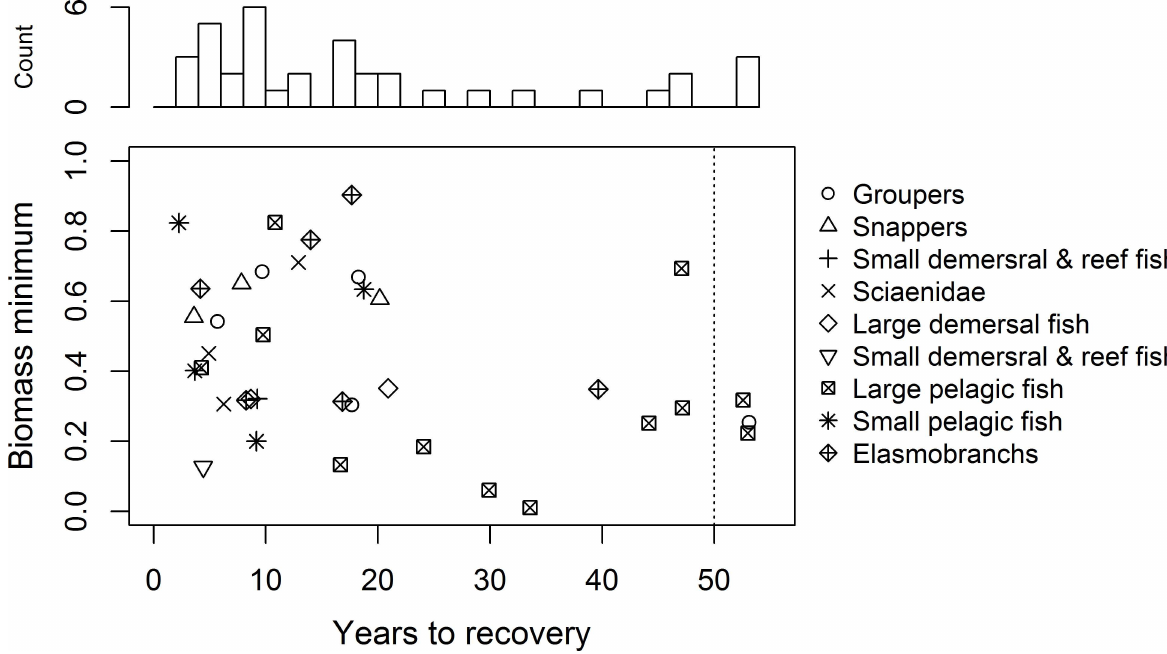
Fig 3. Biomass minima versus years to recovery. Data are relative to no-oil scenario. Criterion for recovery: achieving 99% of biomass of the no- oil scenario. Functional groups > 50 years to recovery did not recover within simulation period. Points show Atlantis functional groups arranged by guild. Represents oil simulation [K1000 β